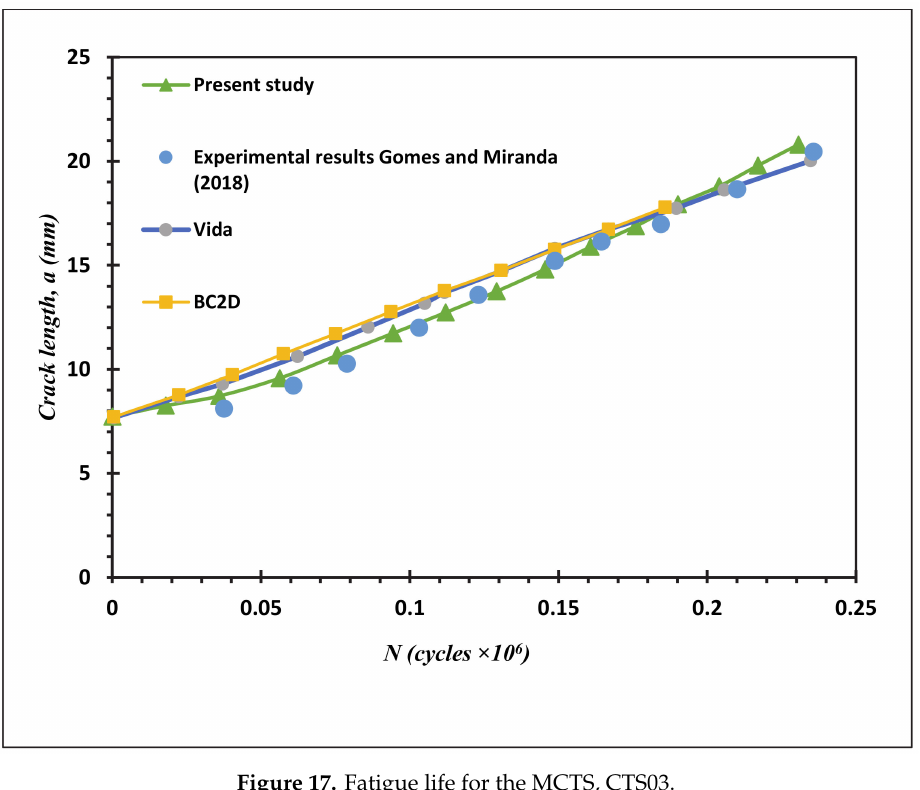
Figure 17. Fatigue life for the MCTS, CTS03.